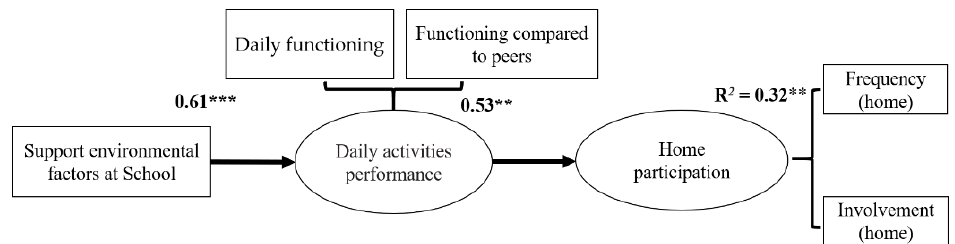
Figure 2. Analysis results of conceptual model mediation. Coefficients in bold are significant at p < 0.05. ** p < 0.01, *** p < 0.001.